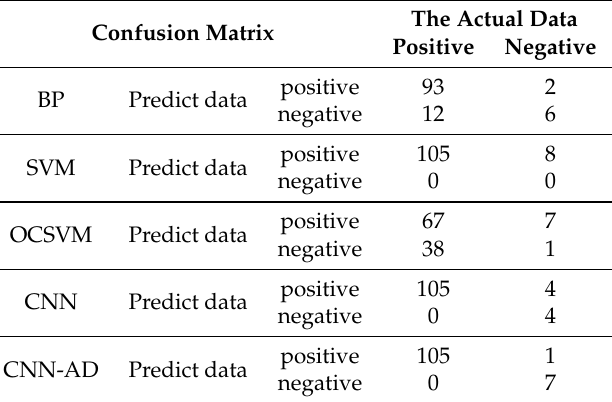
Table 5. Confusion Matrix of Models.